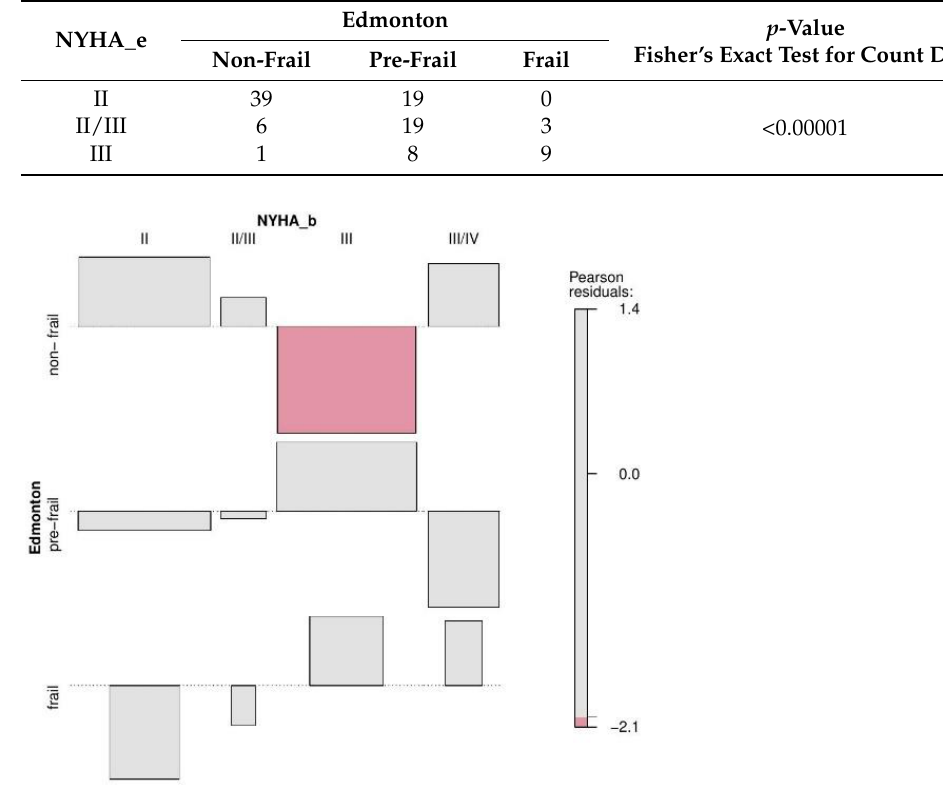
Table 4. Contingency table of Edmonton scale variables—NYHA class at discharge.